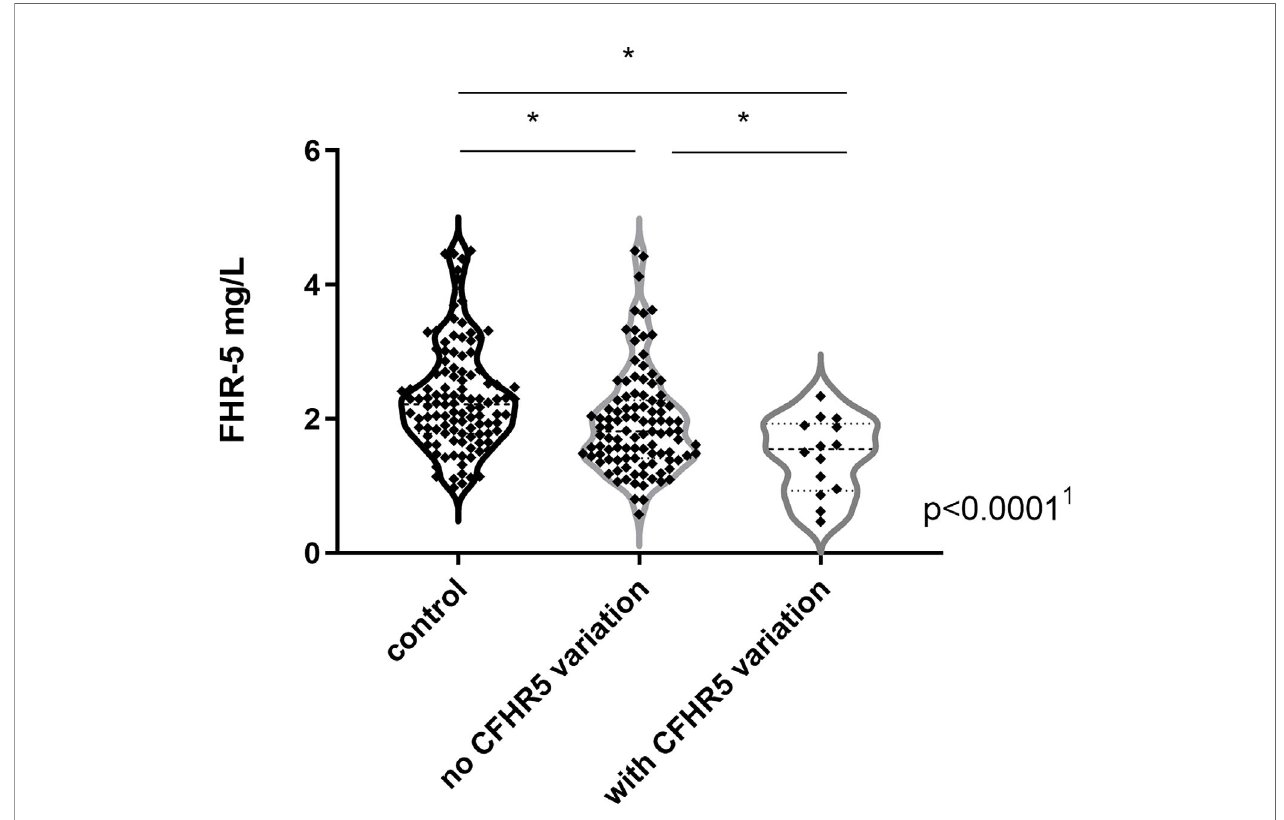
FIGURE 2 | Factor H-related protein 5 (FHR-5) levels in patients with C3 glomerulopathy (C3G)/immune complex-mediated membranoproliferative glomerulonephritis (IC-MPGN) and in healthy individuals. 1 p-value was determined with Kruskal – Wallis test. *p < 0.05 by Dunn ’ s